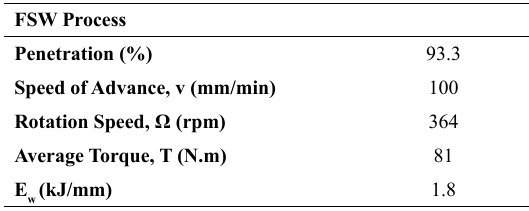
Table 4. FSW parameters and average welding energy.